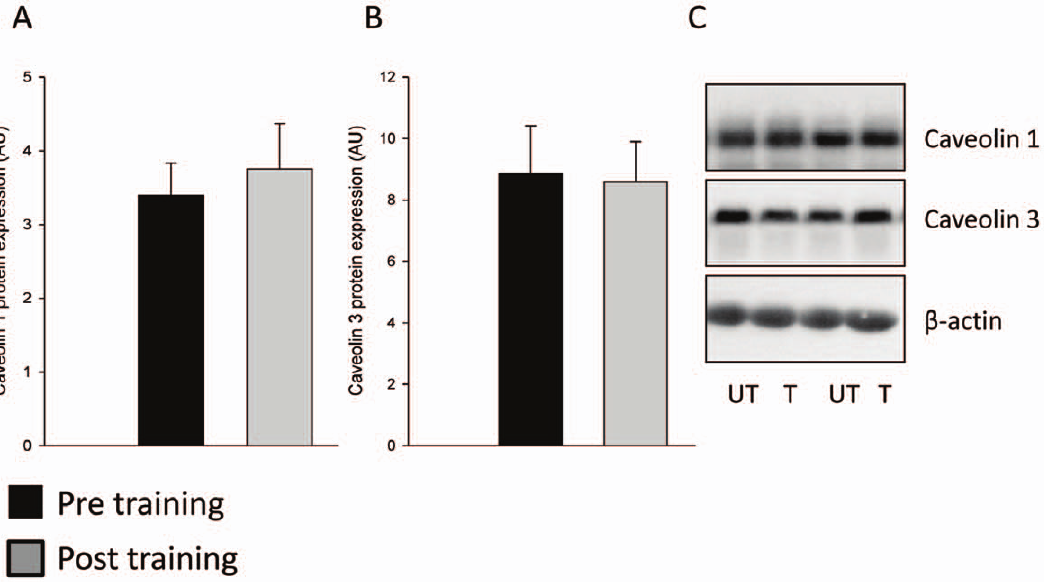
Figure 4. The Caveolae proteins Caveolin1 and Caveolin 3 were unaffected by exercise training. Eight weeks of endurance exercise training did not affect (A) Caveolin 1 and (B) Caveolin 3 protein levels. Protein concentration of TCM fractions pre- and post training were determined and equal protein amounts were resolved by SDS-PAGE and membranes were immunoblotted using antibodies specific for Caveolin 1 and Caveolin 3. b -actin was run on membranes as control and was unchanged with exercise training. Representative Western blots of protein levels before (Pre) and after the exercise training period (Post) from the same subjects are shown (C). Black bars represents pre training values and grey bars represents post training values.